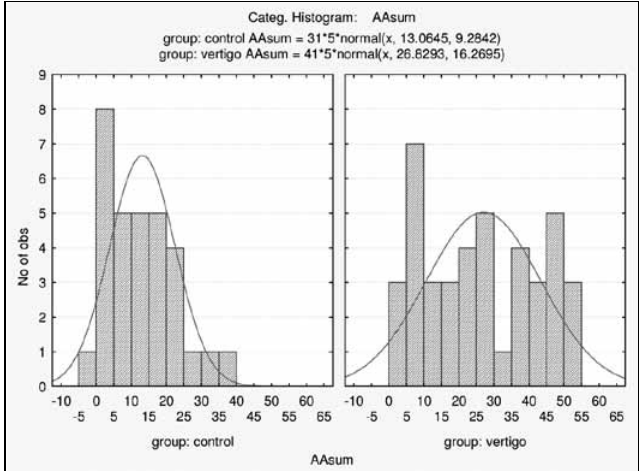
Fig. 3. Histograms depicting the spread of scores obtained on the AA subscale. Scores for the control group are displayed in the left diagram. Scores obtained on the AA are found on the x-axis. Overall, the vertiginous sample scored higher on the AA.